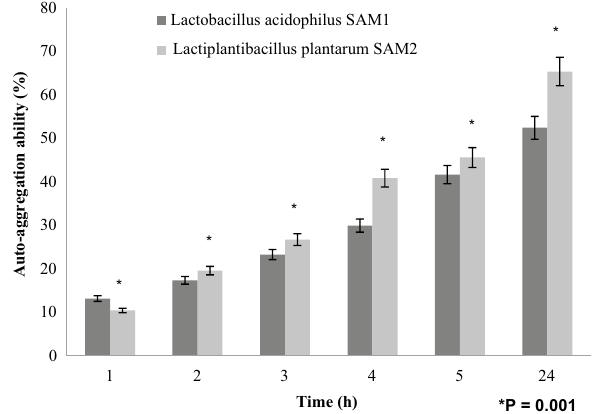
Figure 7. Auto-aggregation ability (%) of LAB strains.